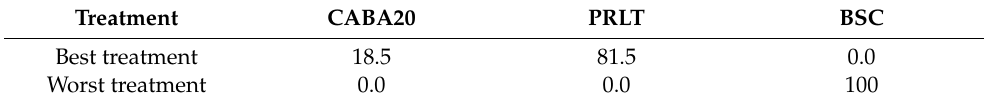
Table 4. Ranking of treatments regarding radiographic progression-free